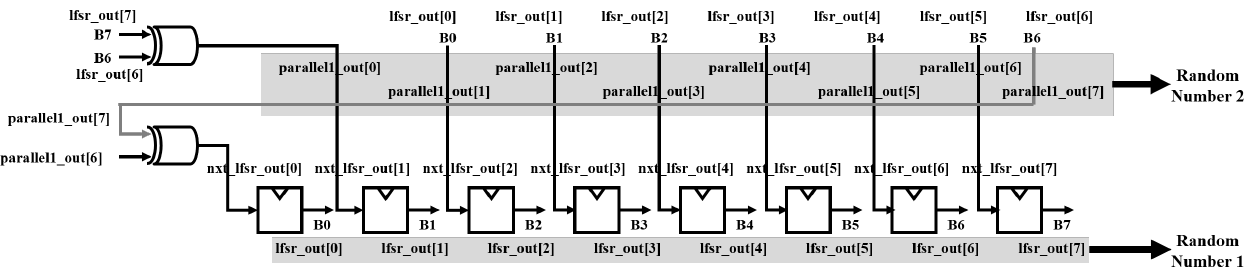
Figure 14. Circuit of 2-stage parallel